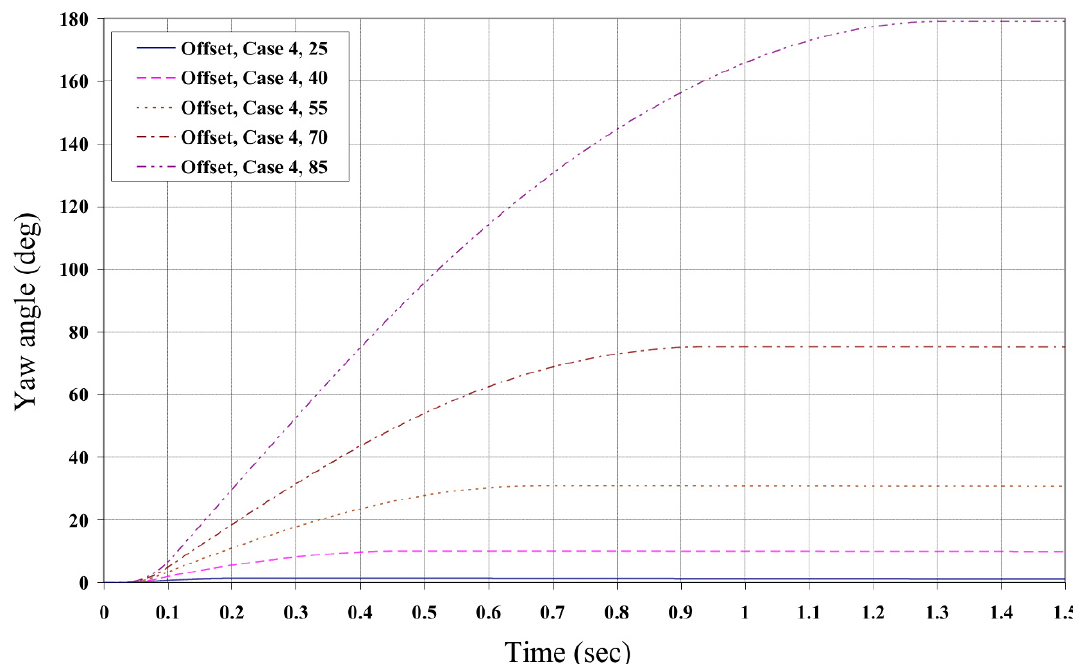
Figure 26. Yaw angle of the vehicle body at the different five speeds with case